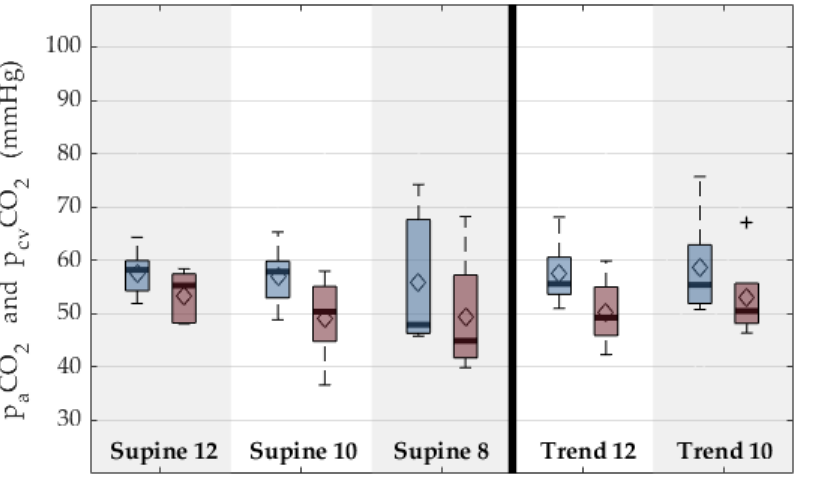
Figure 12 . Mixed venous and arterial oxygen saturations for supine position and reverse Trendelenburg. Each column depicts one group of the experimental sequence. Supine: animal was positioned flat on the back; Trend: 45° reverse Trendelenburg position, simulating a mobilized patient; and 12,10,8: respiratory rate of the intermittent mechanical ventilation, simulating hypercapnic respiratory failure. Blue depicts venous values, and red depicts arterial values.